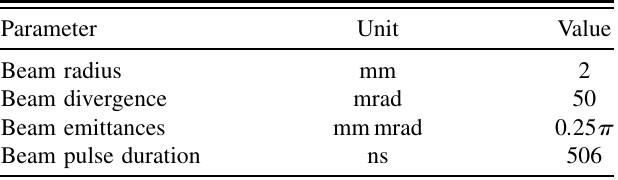
TABLE XII. Ion source beam parameters (emittances are nor- malized).